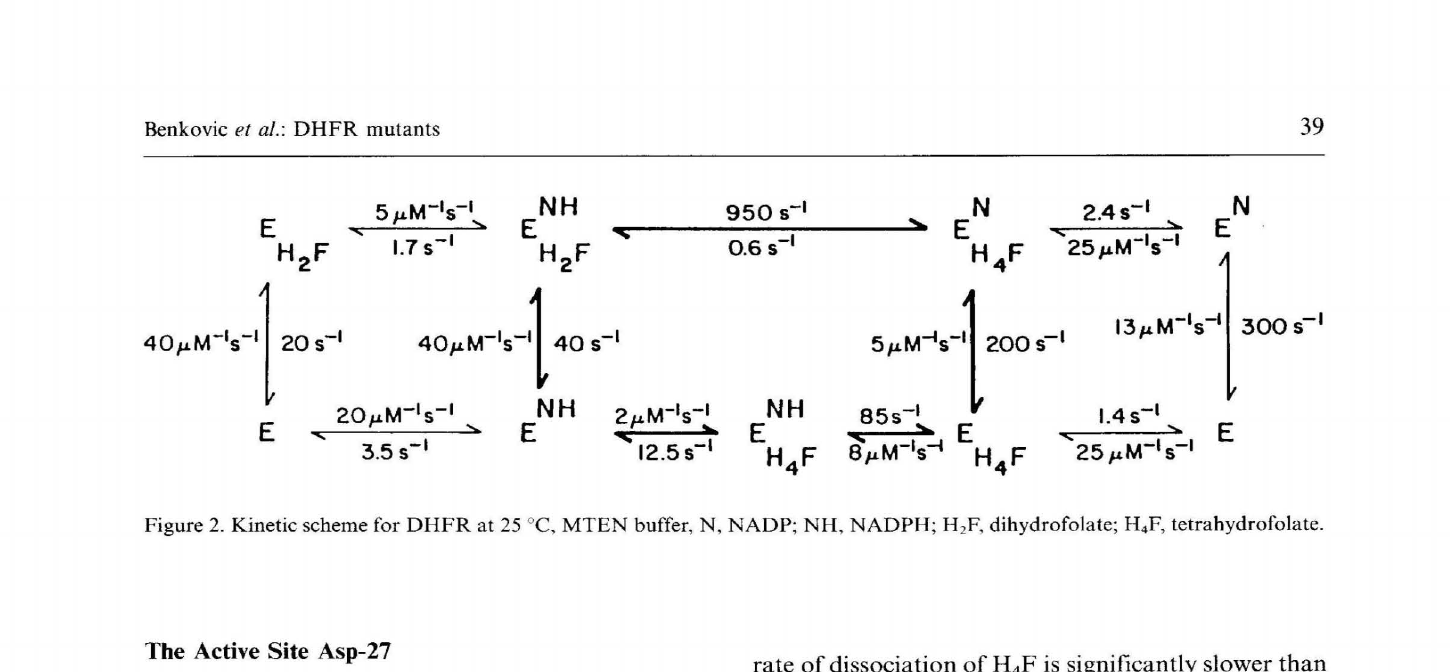
F, dihydrofolate; H4F, tetrahydrofolate. 2